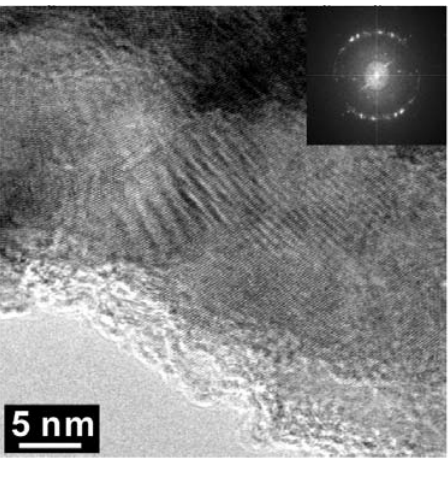
Figure 8. High Resolution-TEM micrograph of the arrowed region in Figure 5. The insert is an FFT (fast Fourier transform)